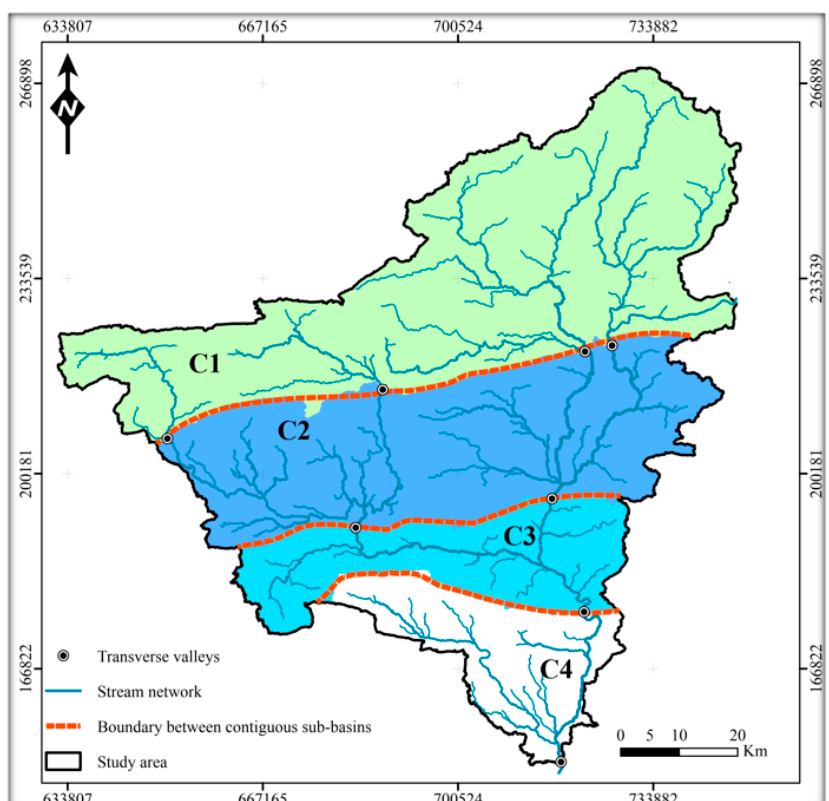
Figure 6. Hydrographic network of Eastern Upper Guir basin divided into sub-basins (C) based on E-W major Atlas structures, surface flow directions and water gaps.